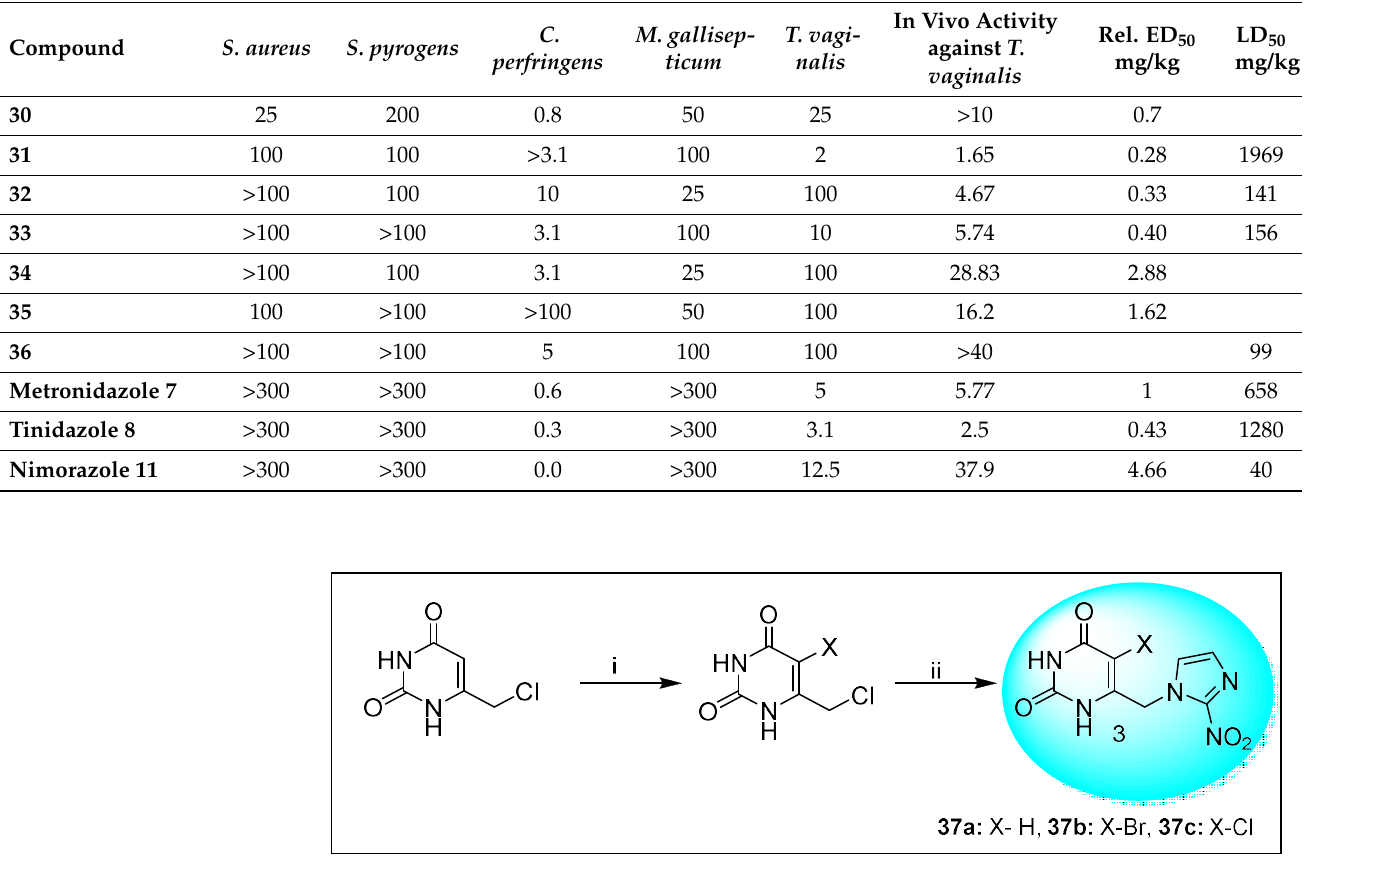
Scheme 11. Synthesis of nitro and aminoimidazolyluracil conjugates. Reagents and conditions: ( i ) NCS or NBS, AcOH, 60 ◦ C, 37a (67%), 37b (77%); ( ii ) 1-potassio-2-nitroimidazole, DMF, rt, N2, 24 h; 37a (61%), 37b (75%), 37c